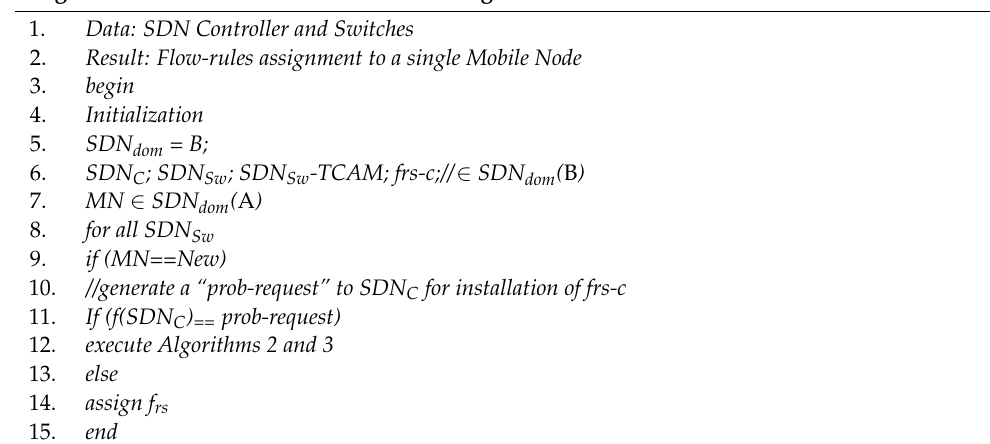
Algorithm 1: For a new Mobile Node Serving SDN Domain